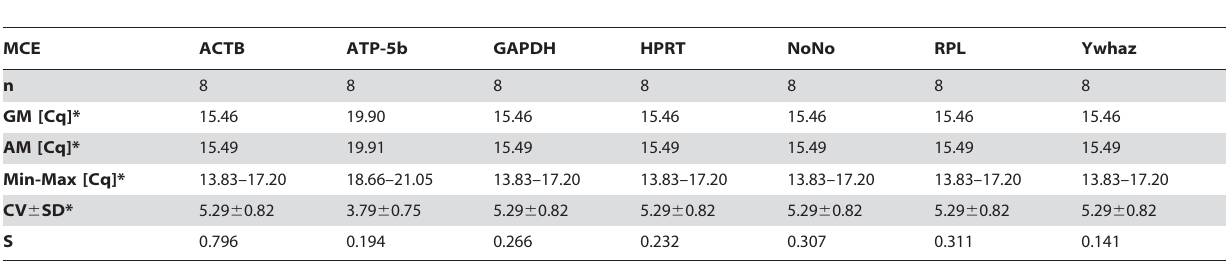
Table 4. Analysis of RGs expression stability during MCE using BestKeeper and NormFinder algorithms.